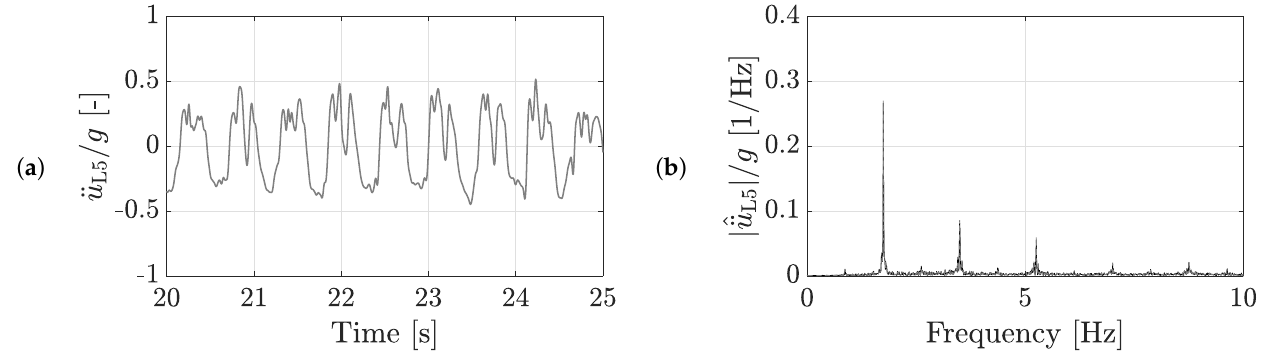
Figure 3. Vertical L5 acceleration with the static component removed of the reference trial: ( a ) time series and ( b ) amplitude spectrum normalized to the gravity